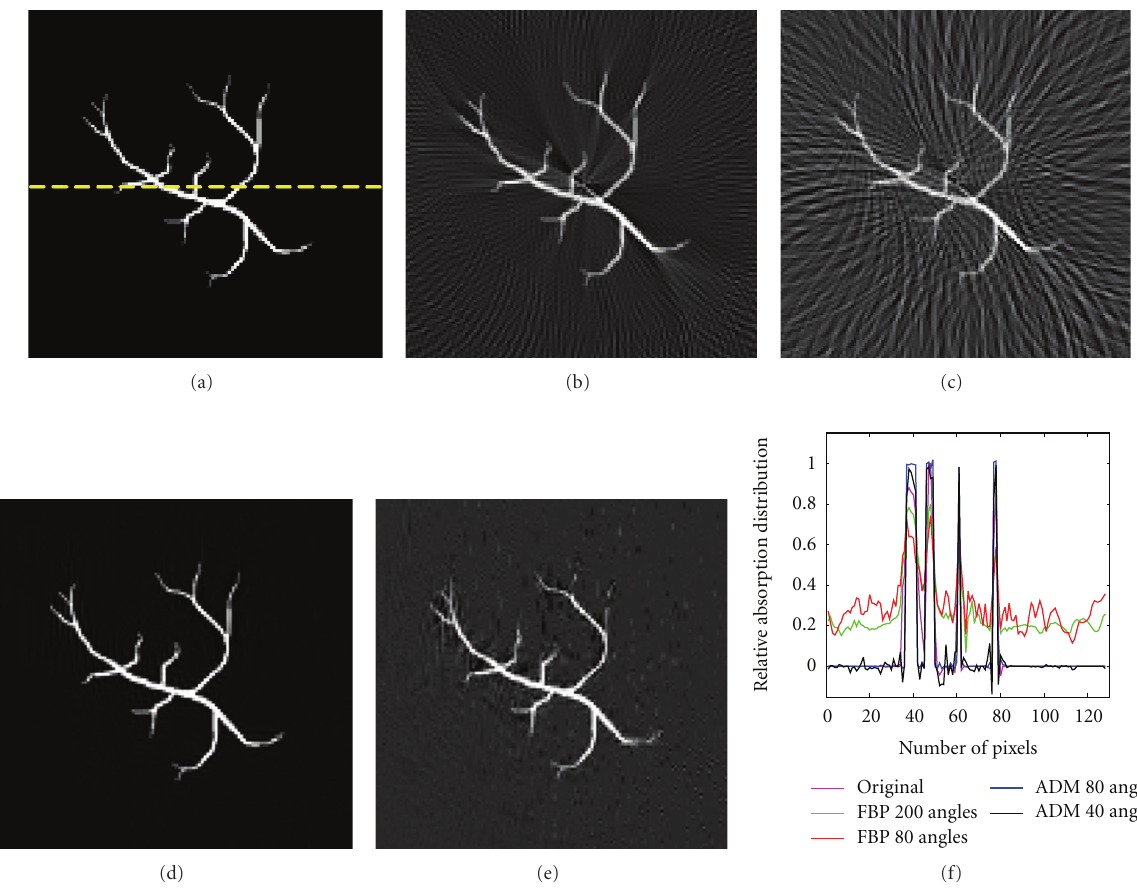
Figure 1: Image reconstructions using the FBP method and ADM algorithm. (a) Original phantom. (b) and (c) image reconstructions using the FBP method with 200 and 80 transducers evenly covering the circle. (d) and (e) image reconstructions using the ADM method with 80 and 40 transducers uniformly covering the 90-degree view. (f) Center lines extracted from (a) to (e).